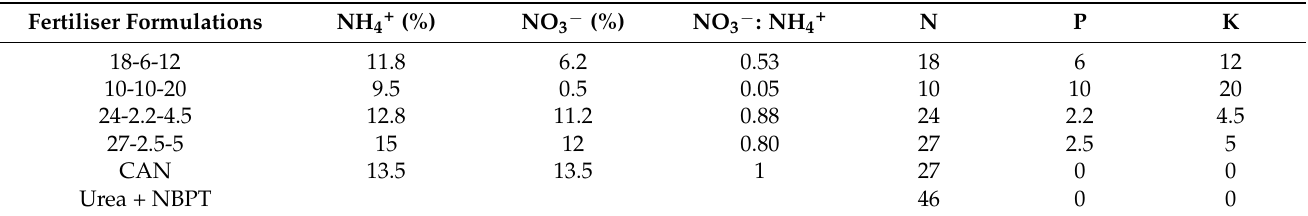
Figure 1. Photograph of experimental field (grassland) at Johnstown Castle research site during gas sampling from static chambers with the square collars inserted into the soil and lead covers closed with ballast weights placed on top. Table 2. Fertiliser formulations and their nutrient contents (%) including nitrate to ammonium ratios.